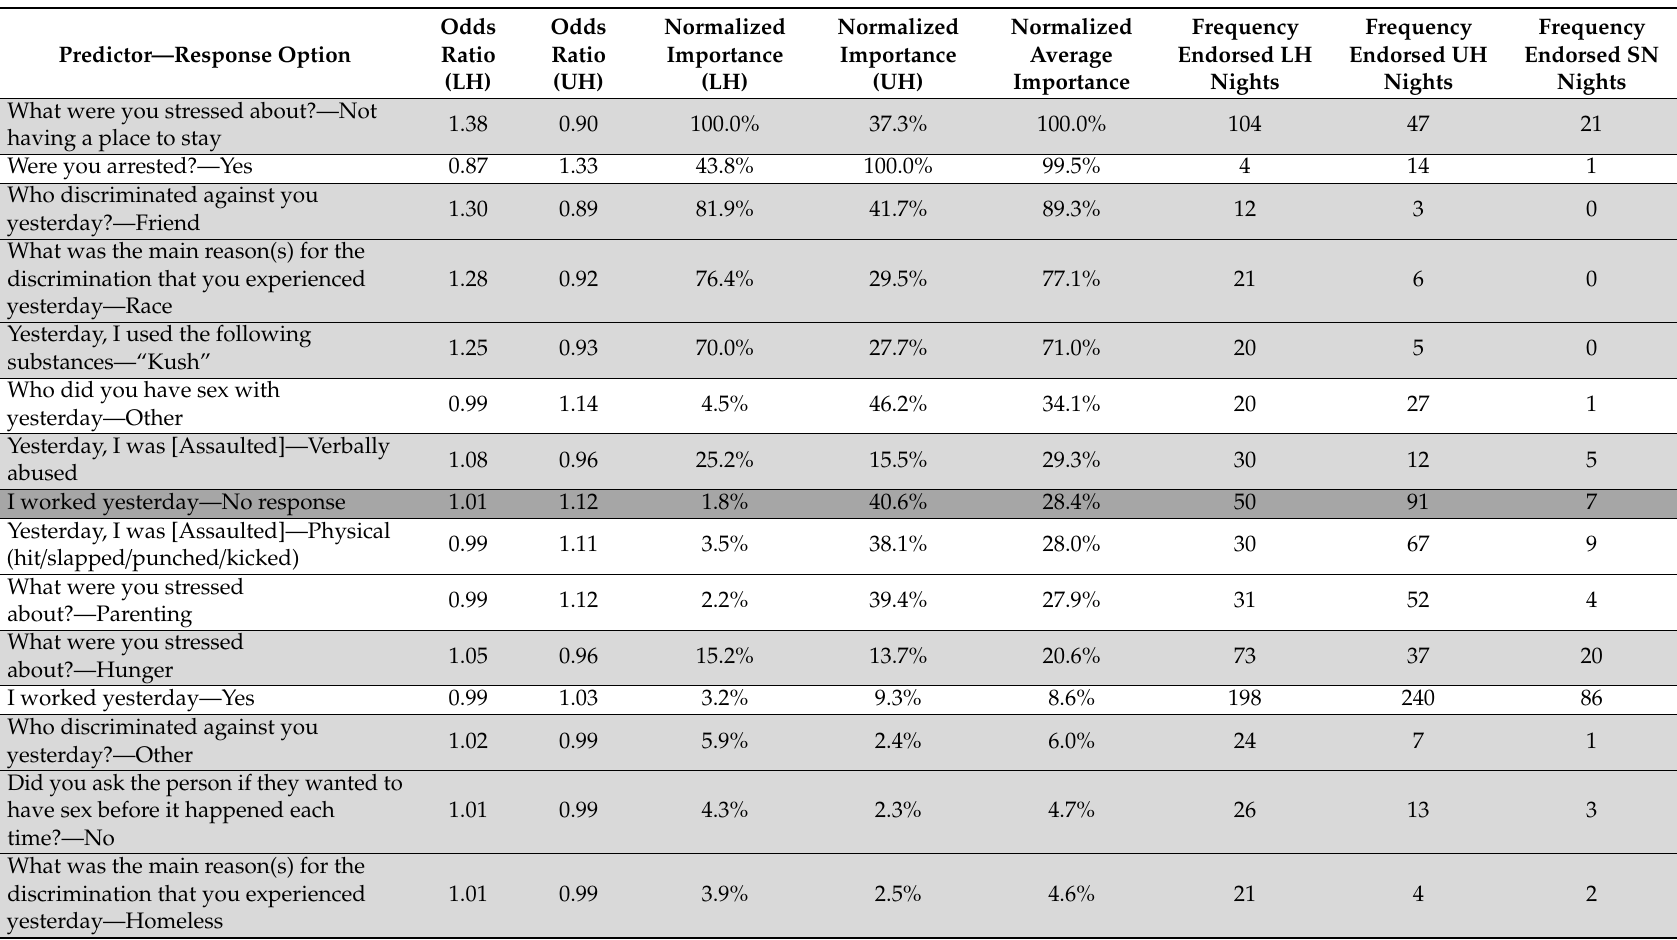
Table 1. Component-wise gradient boosting—reduced model. Outcome predicted categories: literally homeless (LH) or unstable housing (UH) as opposed to sheltered night); OR > 1.0 indicate greater odds of a LH or UH night relative to a SN, while OR < 1.0 indicate lower odds relative to a SN. No shading—odds UH > SN > LH; light gray—odds LH > SN > UH; dark gray—UH > LH > SN. Results ordered by normalized average importance (high to